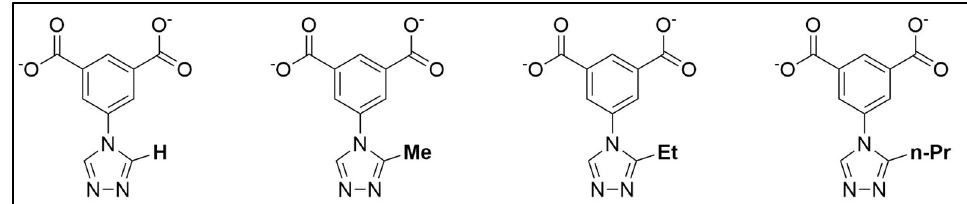
Figure 1. Illustration of organic linkers for the MOFs Cu-IH-pw , Cu-IHMe-pw , Cu-IHEt-pw , and Cu-IHnPr-pw from left to right. The differences are within the alkyl side-chain in the 2-position of the triazolyl